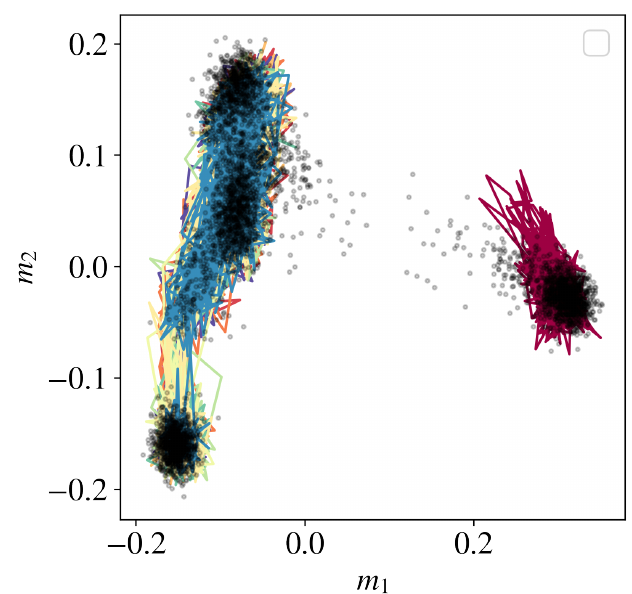
Figure 10: We show the training dataset projected along the second and third prin- cipal directions (namely m and m ) in black dots. The samples are grouped in 1 2 separate clusters. In the colored solid lines, we show different SMC sampling tra- ( t ) , m ( t ) } jectories { m of 10 5 MC sweeps extracted from a TMC-RBM trained for t 1 2 = 1000 updates, λ = 0.01 and k = 10. One can clearly appreciate that there is t age no jump between the high and low m sectors during this 1